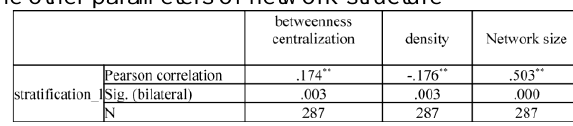
Table 4. Correlations between stratification and